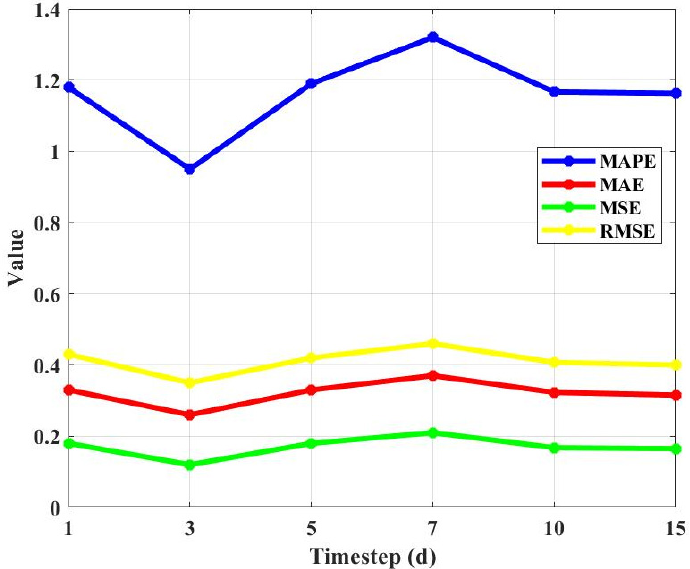
Figure 10. The experimental results of the new hybrid SST correction model in different timesteps. The units of RMSE, MAE, and MSE are ◦ C, the unit of MAPE is %, and the unit of timestep is day.